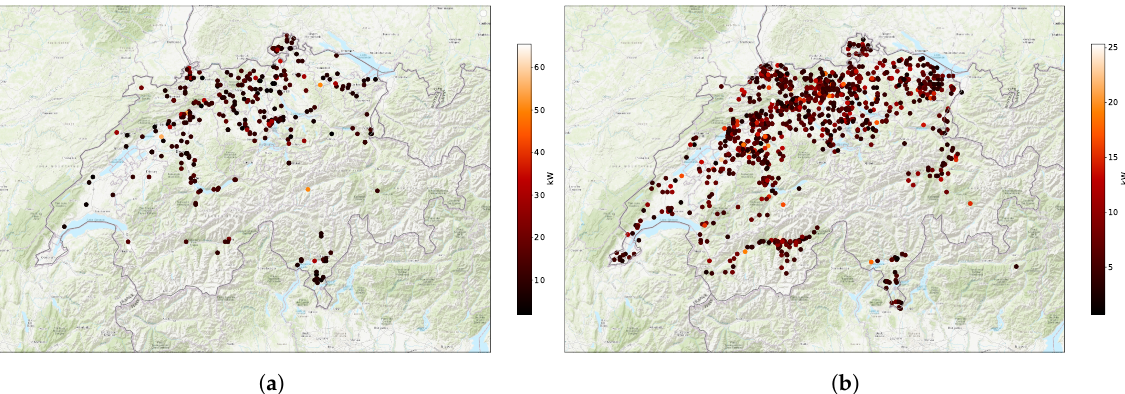
Figure 5. Spatial distribution of the different datasets. ( a ) Real dataset. ( b ) Synthetic dataset. Colors indicate the peak production of each